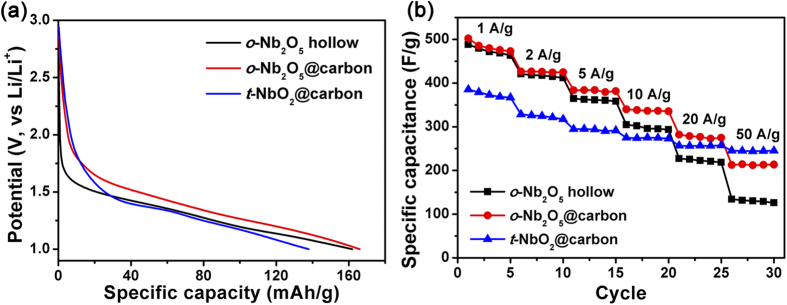
Galvanostatic charge-discharge curves (a) and rate capability (b) of o-Nb2O5 hollow microspheres, t-NbO2@carbon core-shell microspheres and o-Nb2O5@carbon core-shell microspheres.